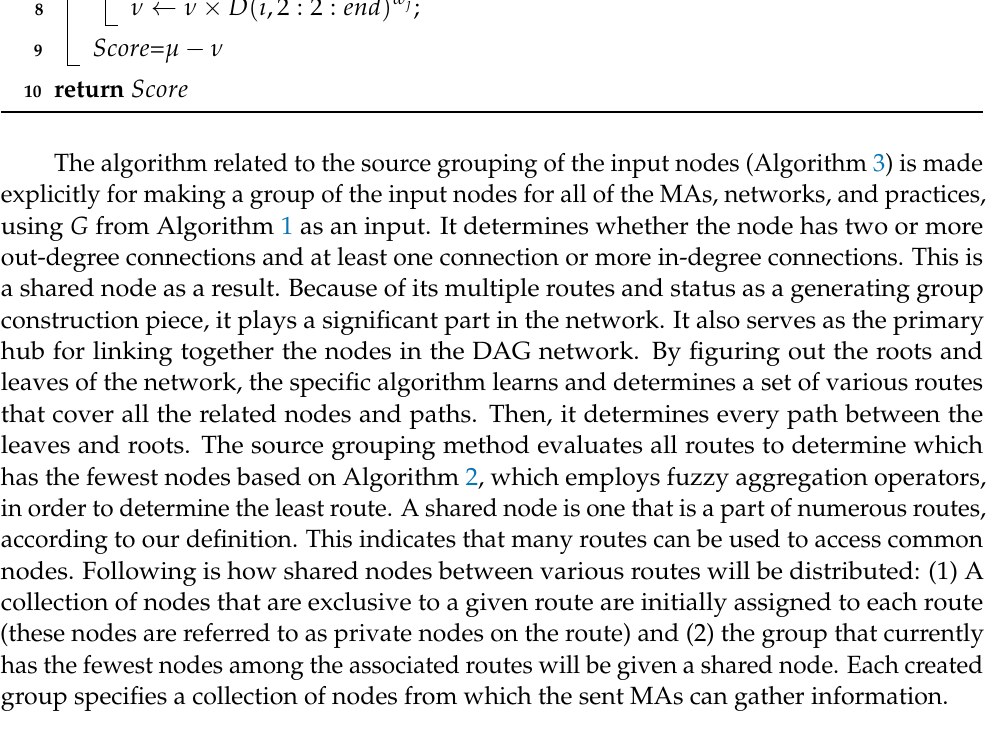
Algorithm 3: Source grouping of sensor